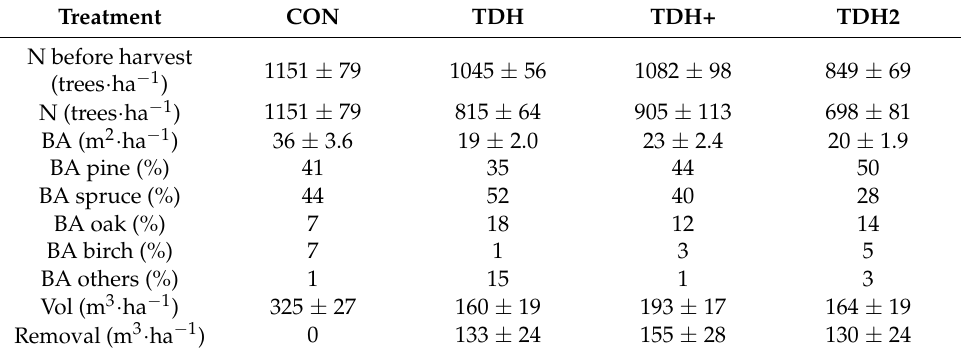
Table 2. Mean and standard errors of post-harvest stand characteristics for the four experimental